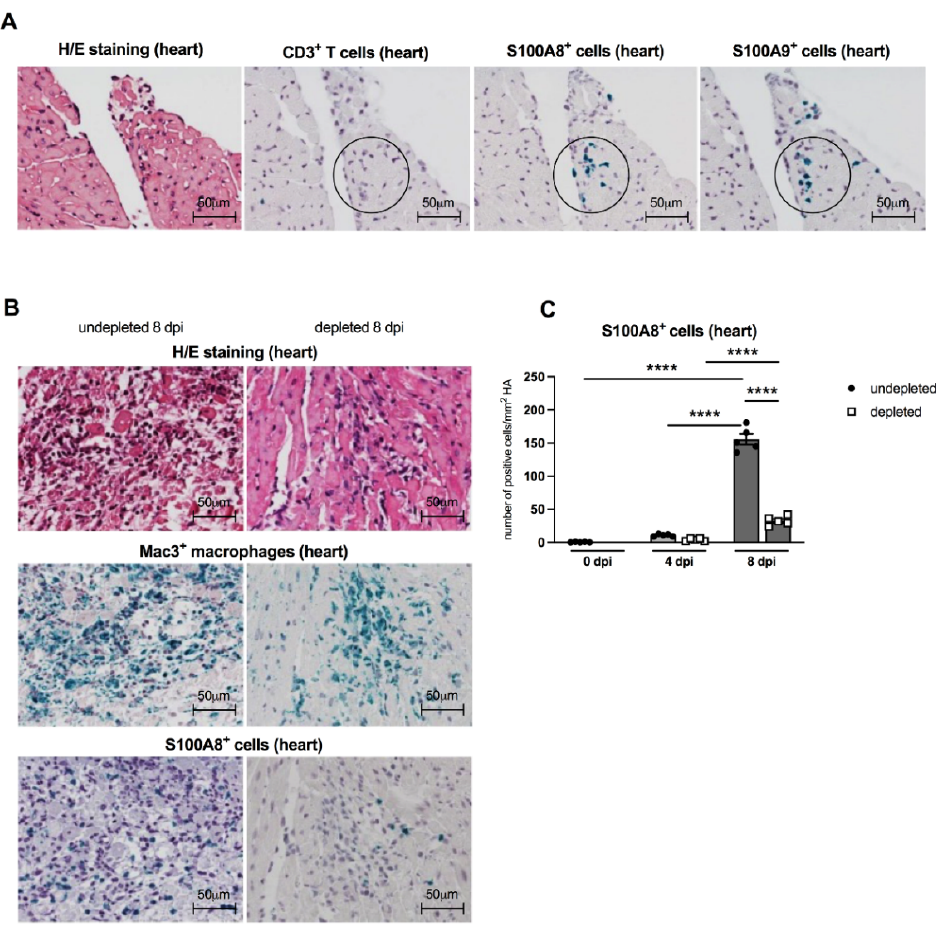
Figure 5. Cardiac S100A8- and S100A9-expressing cells are present before CD3 + T lymphocyte infiltration, and Gr-1 depletion results in a decrease of S100A8 protein levels in the heart of CVB3- infected A.BY/SnJ mice. ( A ) Representative H/E and immunohistological stainings for CD3 + T lymphocytes, S100A8, and S100A9 (see circles for positive green cells) in serial heart tissue sections of CVB3-infected mice 4 dpi (magnification × 400). Hearts from CVB3-infected mice with or without Gr-1-depletion were subjected to ( B ) H/E (upper panel), and immunohistochemical stainings of Mac3 + macrophages (middle panel, green cells) and S100A8 protein (lower panel, green cells) 8 dpi (magnification x400). ( C ) Subsequent quantification of S100A8 protein expression as number of positive cells/mm 2 HA. Data are expressed as mean ± SEM and were analyzed with One-way ANOVA (**** p < 0.0001 with n = 5 for 0 dpi, n = 5 for 4 dpi, and n = 5 for 8